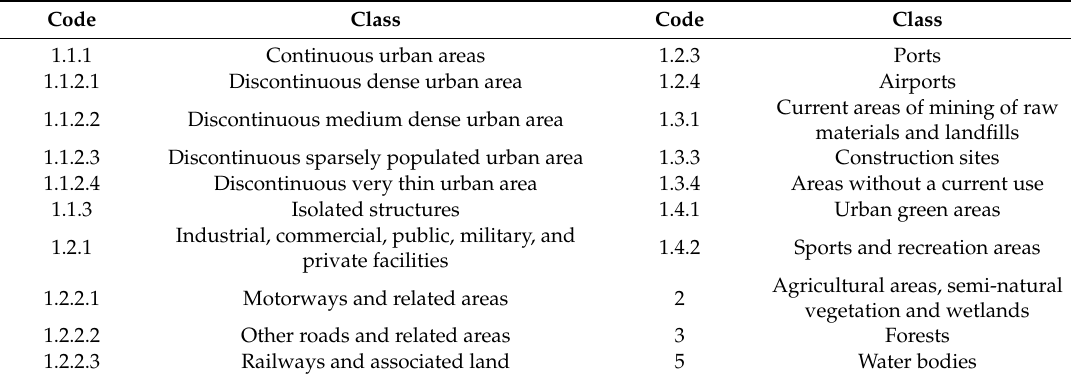
Table 3. The UA nomenclature, UA 2006.